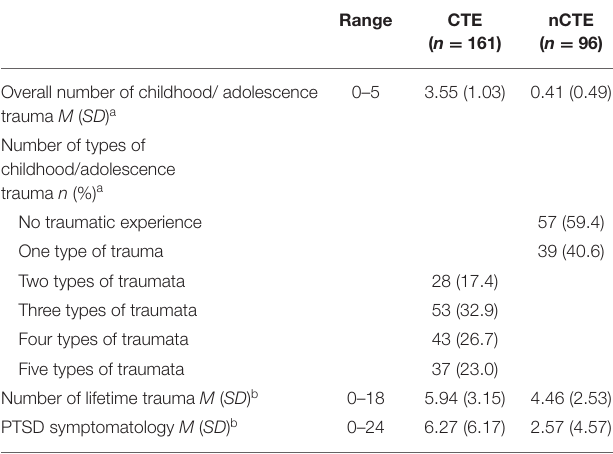
TABLE 2 | Trauma history analysis and PTSD